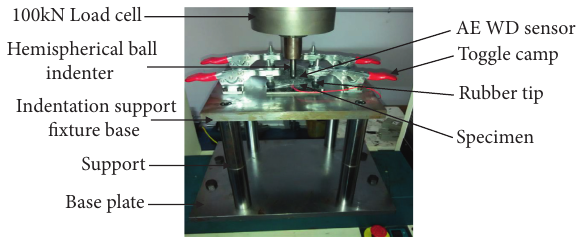
Figure 2: Quasi-static indentation (QSI) testing